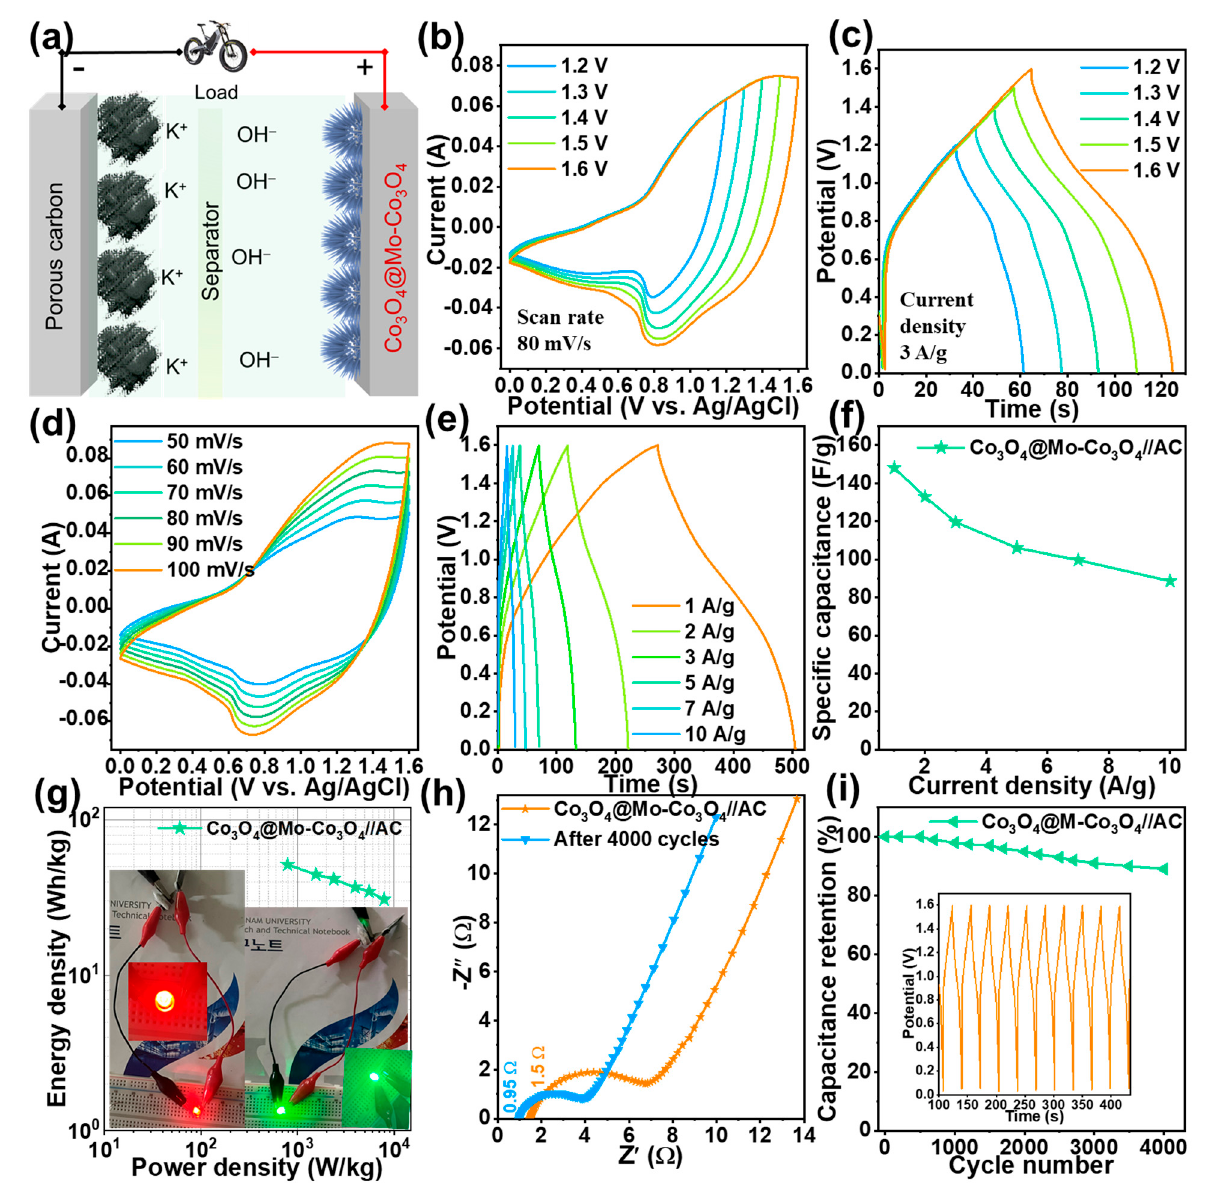
Figure 6. ( a ) Schematic of ASC device, ( b ) CV curves for different voltage windows at an 80-mV/s scan rate, ( c ) GCD curves for different voltage windows at a current density of 3 A/g ( d , e ) CV curves at scan rates of 50–100 mV/s and GCD curves at current densities of 1–10 A/g, ( f ) calculated specific capacitance values, ( g ) Power density vs. energy density plot, ( h ) Nyquist plot of before and after 4000 GCD cycles, ( i ) capacitance retention over 4000 GCD cycles; inset: ten consecutive GCD cycles of Co 3 O 4 @Mo-Co 3 O 4 //AC ASC device.